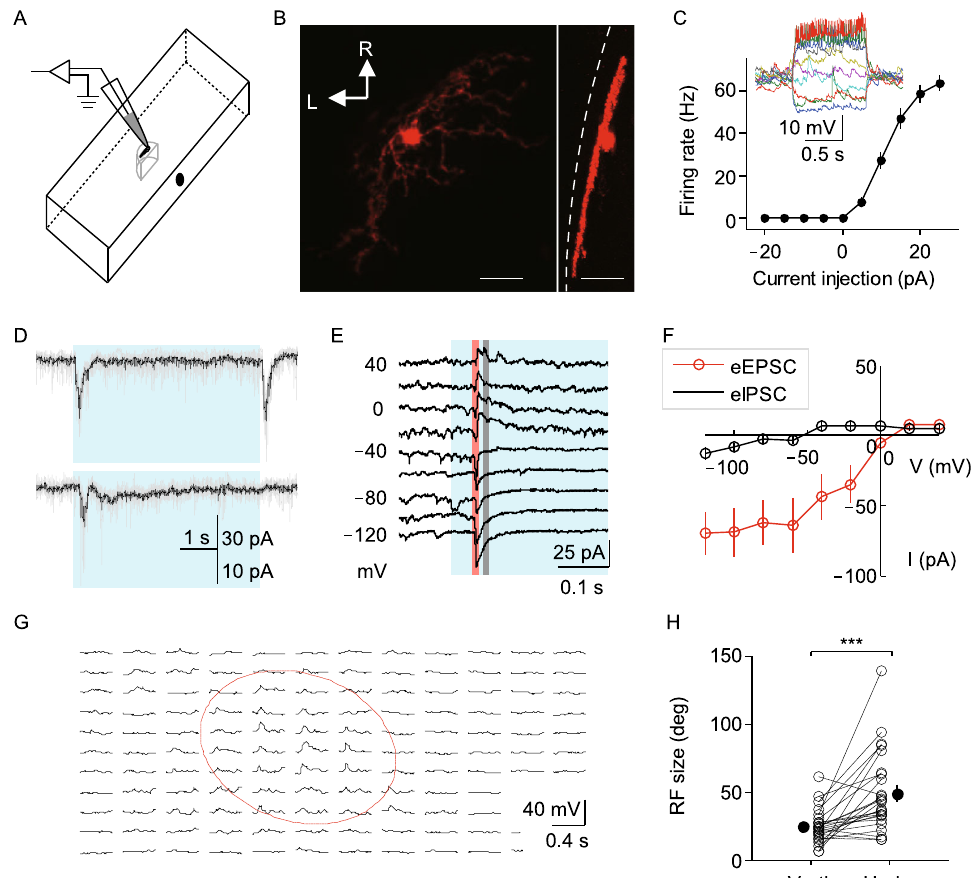
Figure 1. Electrophysiological characterization of SINs. (A) Simpli fi ed schematic showing recording paradigm. Black dot indicates visual stimulation on the screen. (B) In vivo confocal image of single photo-converted SIN. Left: top view; right: side view (77° rotation of image stack). Dashed line indicates location of skin above the surface of the tectum. (C) Summary of current- frequency relationship ( n = 56). Inset: voltage traces with current injection. In this and subsequent fi gures, error bars indicate SEM. (D) Current traces showing transient ON/OFF and OFF responses to whole- fi eld stimulation. In this and subsequent fi gures, blue area, gray and black traces indicate stimulation window, individual representations and averaged responses, respectively, unless otherwise mentioned. (E) Current traces with holding potentials from − 120 mV to 40 mV in 20 mV step. (F) Summary of the I – V relationship ( n = 9). (G) Spatial RF (outlined by dashed line) of one SIN. (H) Summary of RF sizes ( n = 25; P = 1.4 × 10 − 4 , Wilcoxon signed-rank test). Scale bar, 20 μ